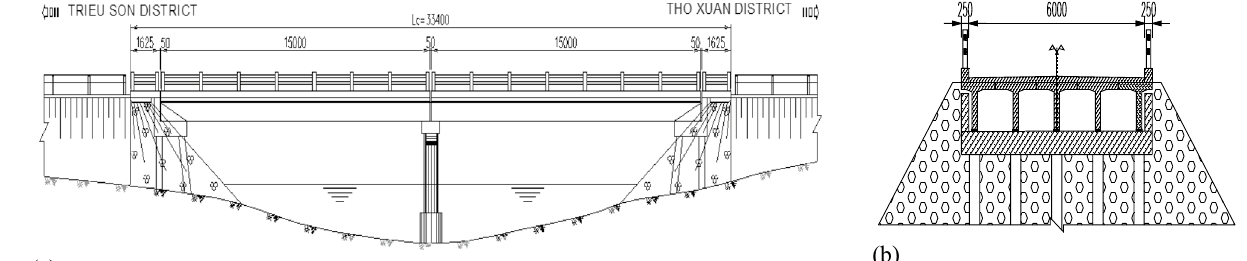
Figure 4. ( a ) The layout of the bridge and ( b ) cross-section of the